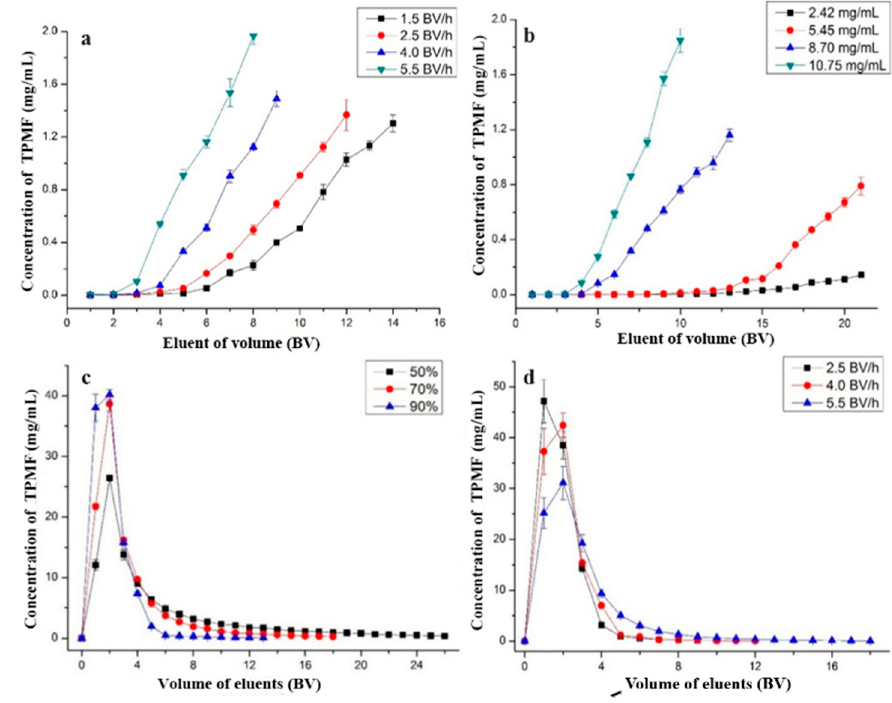
Figure 3. Dynamic breakthrough curve ( a , b ) and dynamic desorption curves ( c , d ) of PMFs on column.